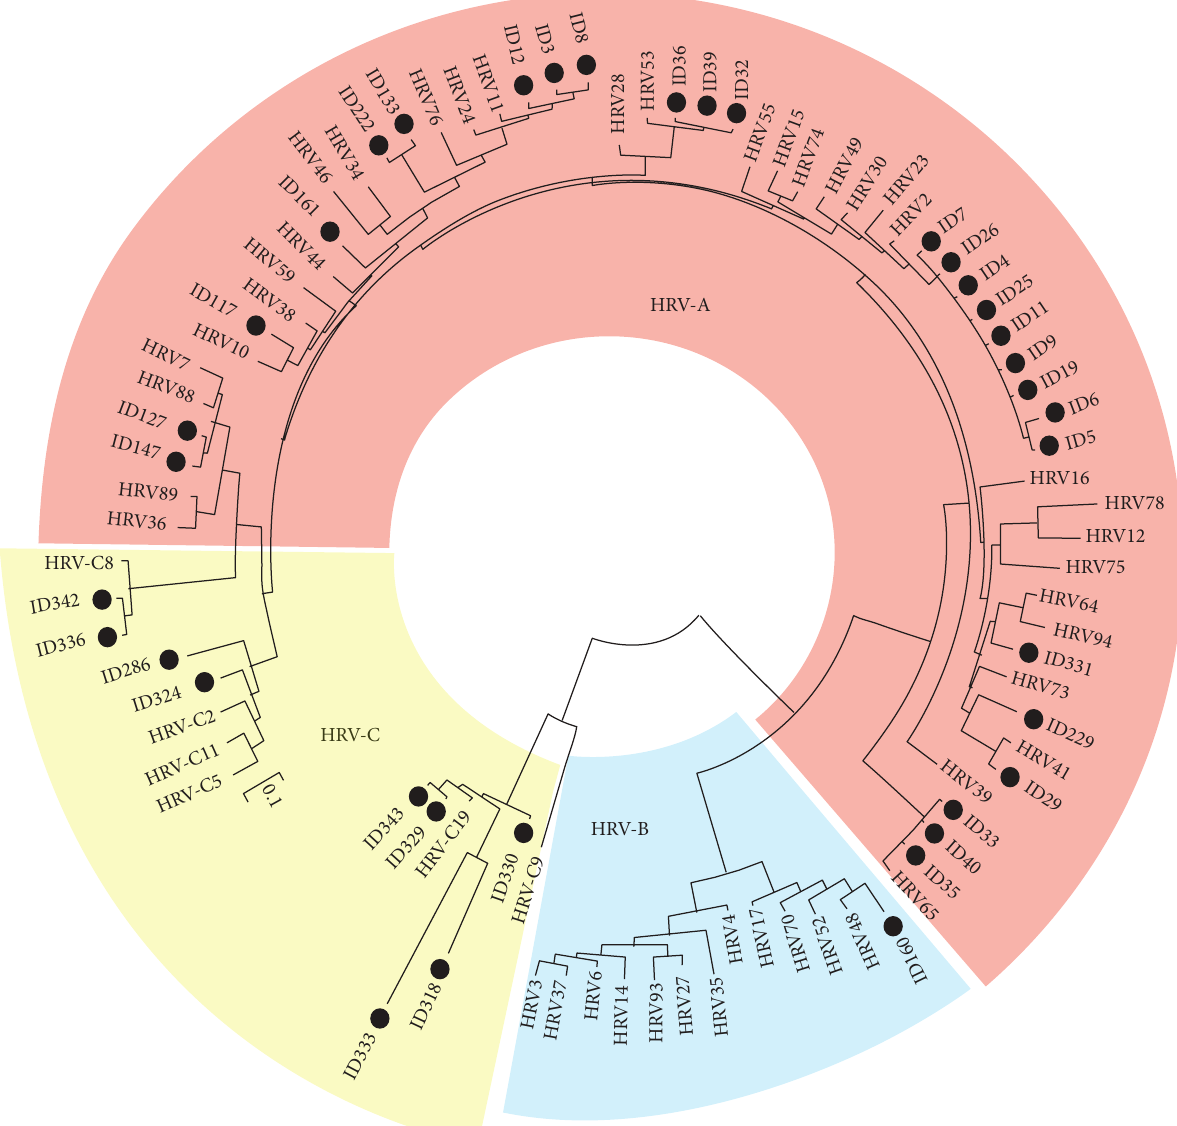
Figure 1: Genotyping of human rhinoviruses amplified from transplant patients. Genetree of human rhinovirus VP1 sequences. Reference sequences were obtained from the Picornavirus Study Group database (http://www.picornastudygroup.com/). Samples amplified from patients are indicated by a filled black